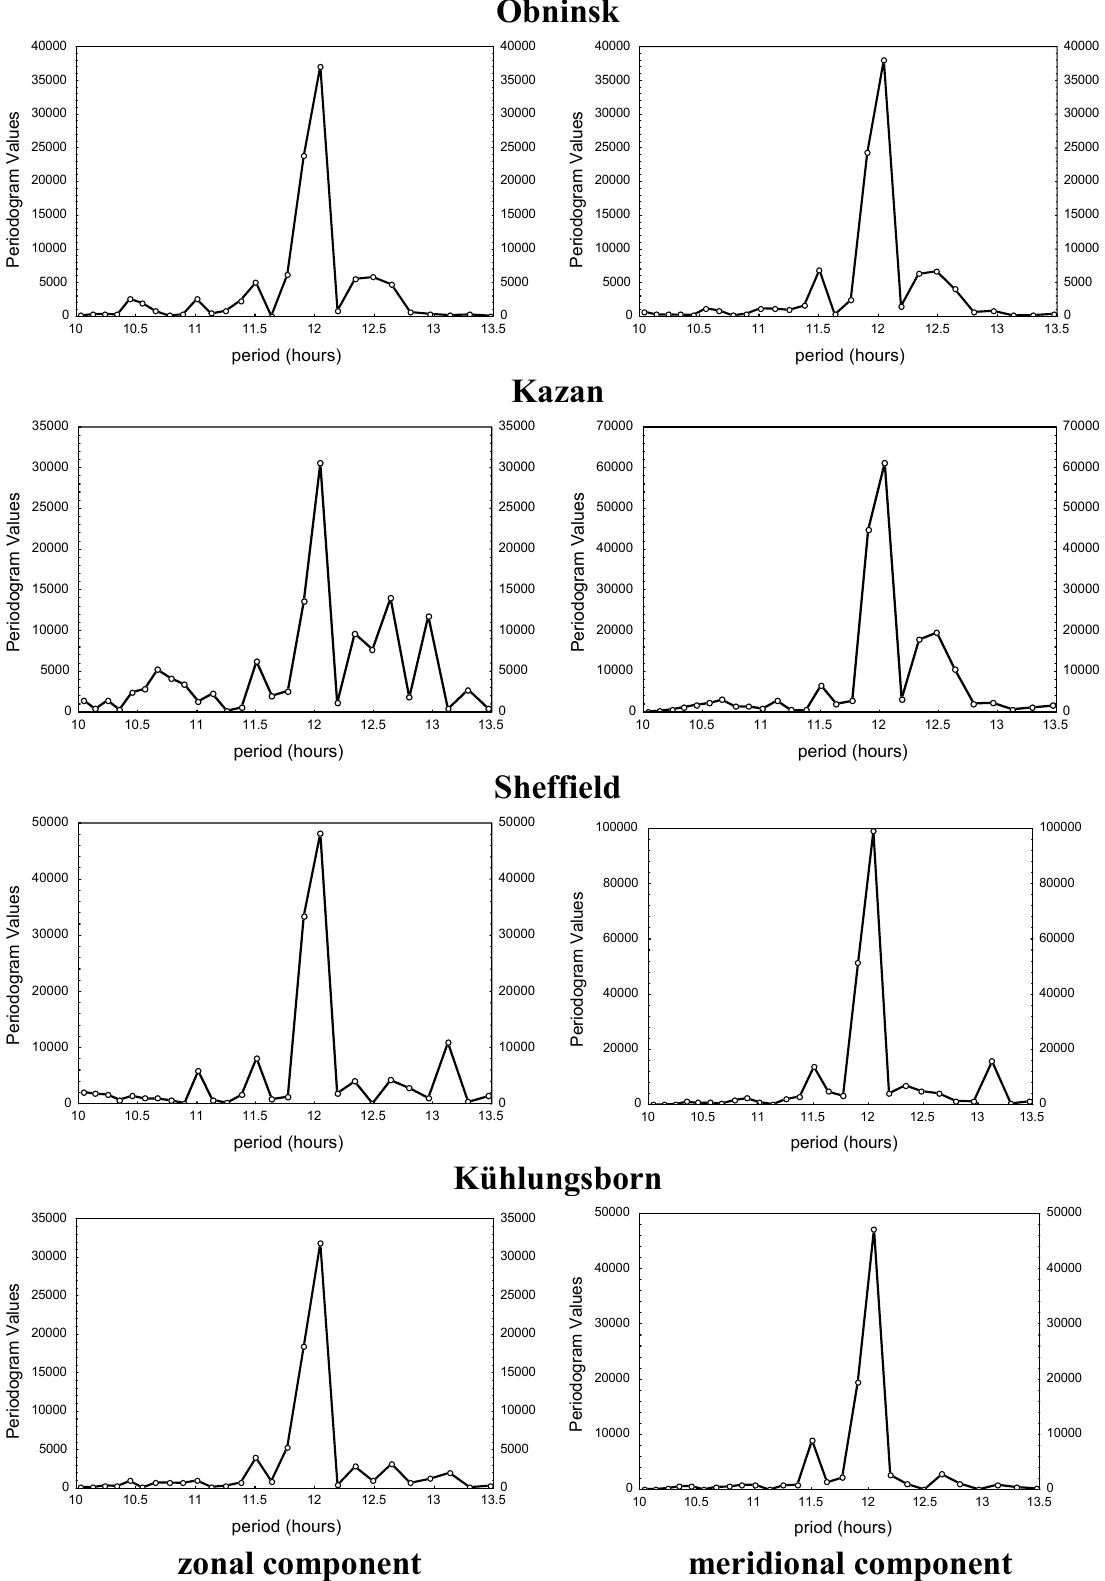
Fig. 7. Periodograms evaluated for the DYANA campaign hourly wind